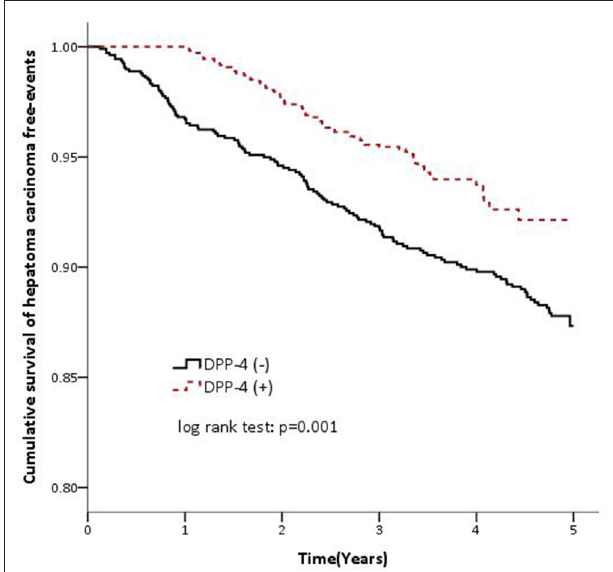
FIGURE 1 | Cumulative survival of hepatoma carcinoma (hepatocellular carcinoma) free events in the DPP-4 inhibitor cohort (dashed line) and non-DPP-4 inhibitor cohort (solid